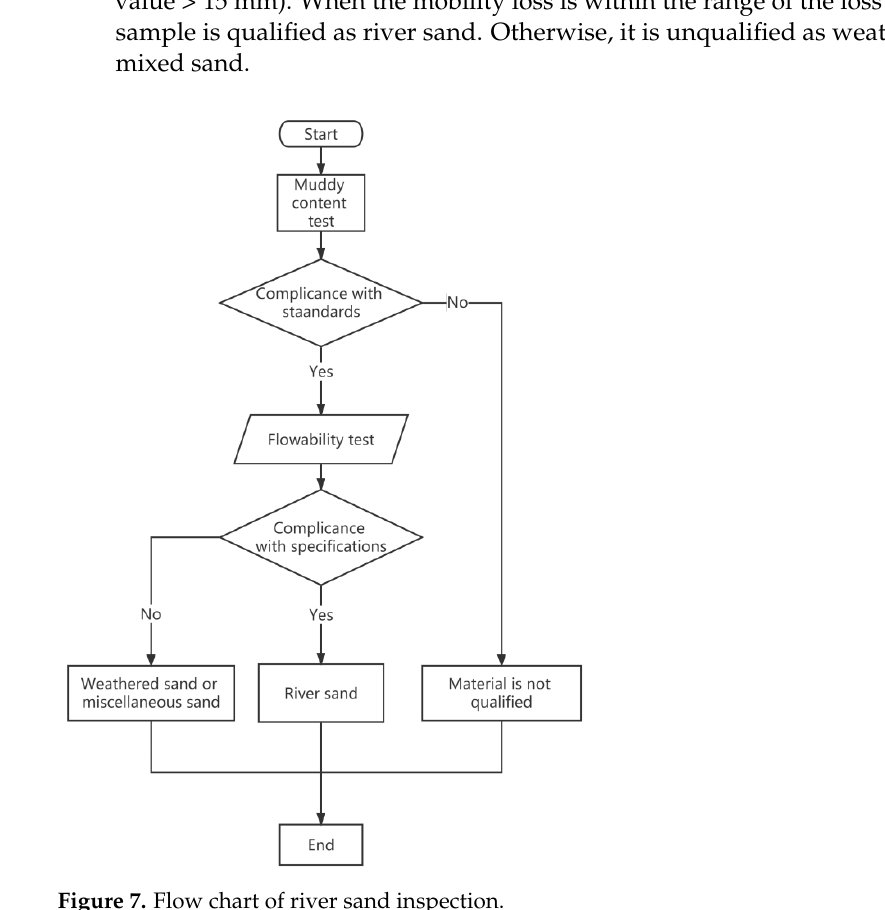
Figure 7. Flow chart of river sand inspection .